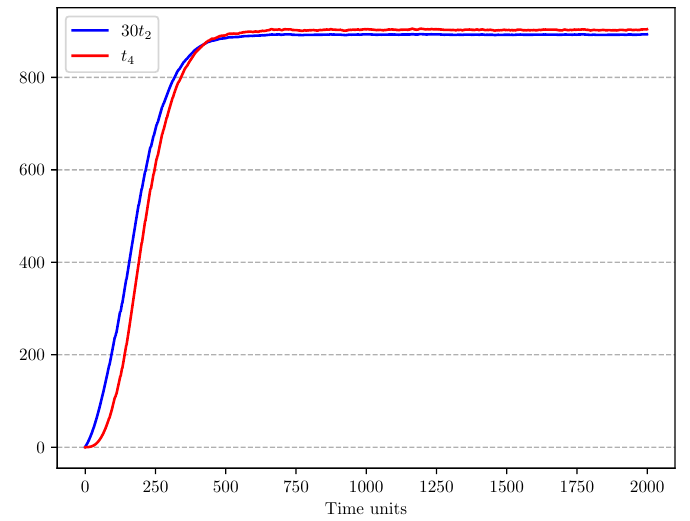
Figure 9: We show t and t obtained from MC. The values we obtain for this specific 2 4 = 29.73 ( 3 ) and t = 903 ( 3 ) . This took about stream of run is for N = 300 with t 2 4 3.5 hours on a laptop since it thermalizes late compared to symmetric case and we need to run for a longer time. This specific dataset corresponds to the red point in Fig.